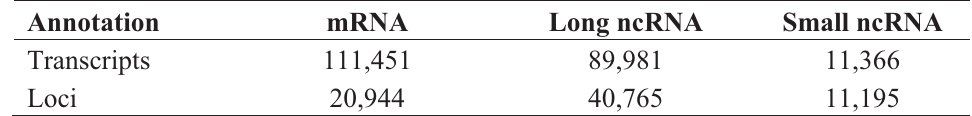
Table 1. Number of known annotated transcripts and human gene loci collected from Ense mbl, NCBI’s RefSeq, UCSC Genome Browser, and Cabili et al .’s lincRNA catalog. A single locus typically contains multiple transcripts, particularly for